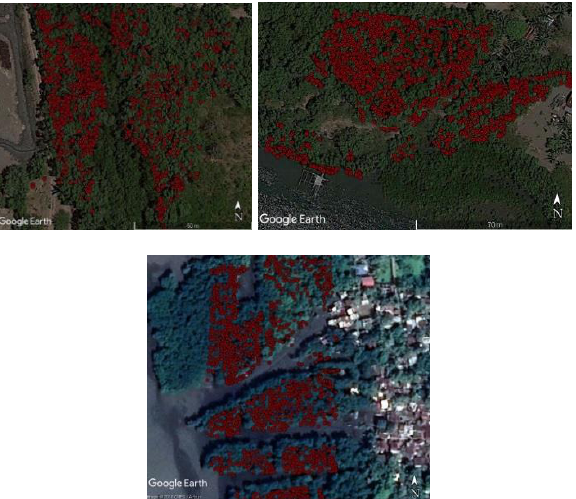
Figure 1. Study sites in San Juan, Batangas (dense mangrove forest; above) and in Masinloc, Zambales (sparse mangrove forest; below). Red dots indicate inventoried trees